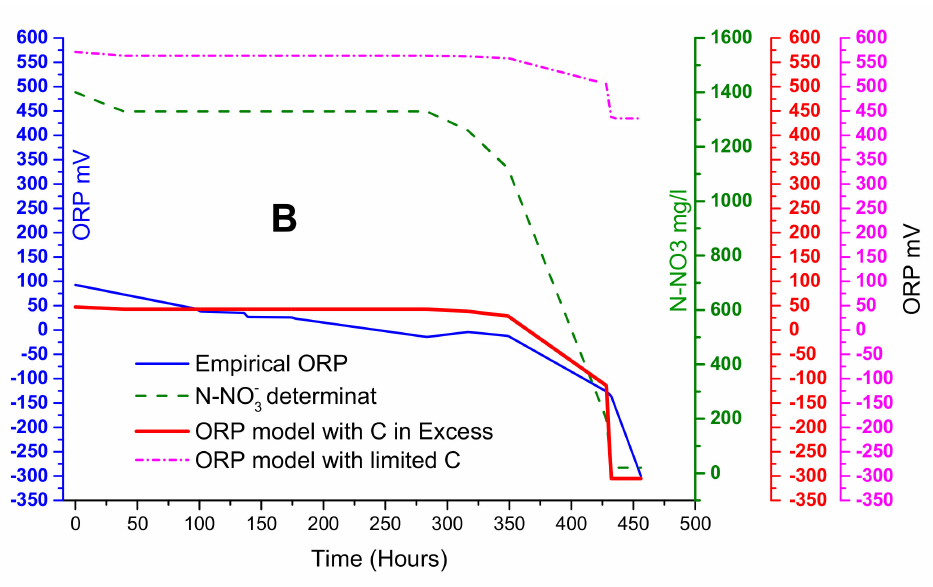
Figure 5. ( A ) Empirical determination of ORP and N-NO 3 − mg/L concentration. ( B ) Model of denitrification and Nernst equation (ORP model) under excess and limited COD